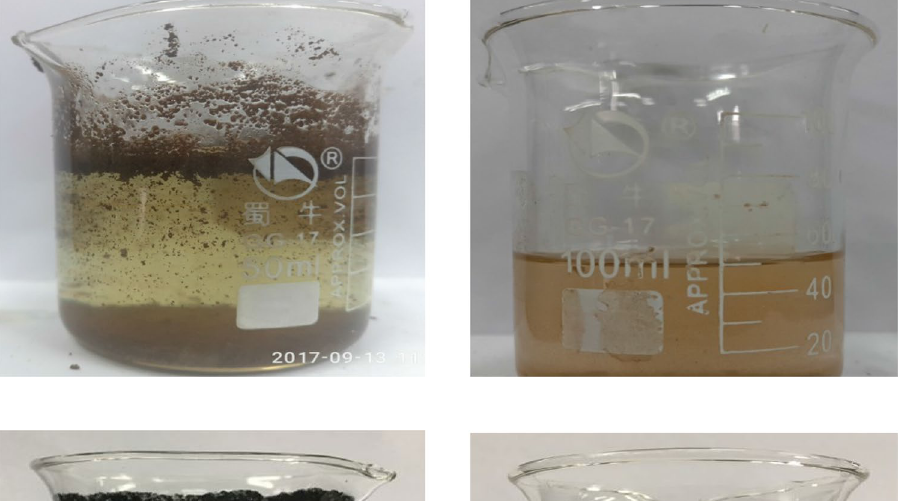
Fig. 8 Reaction results of the tion and ethanol